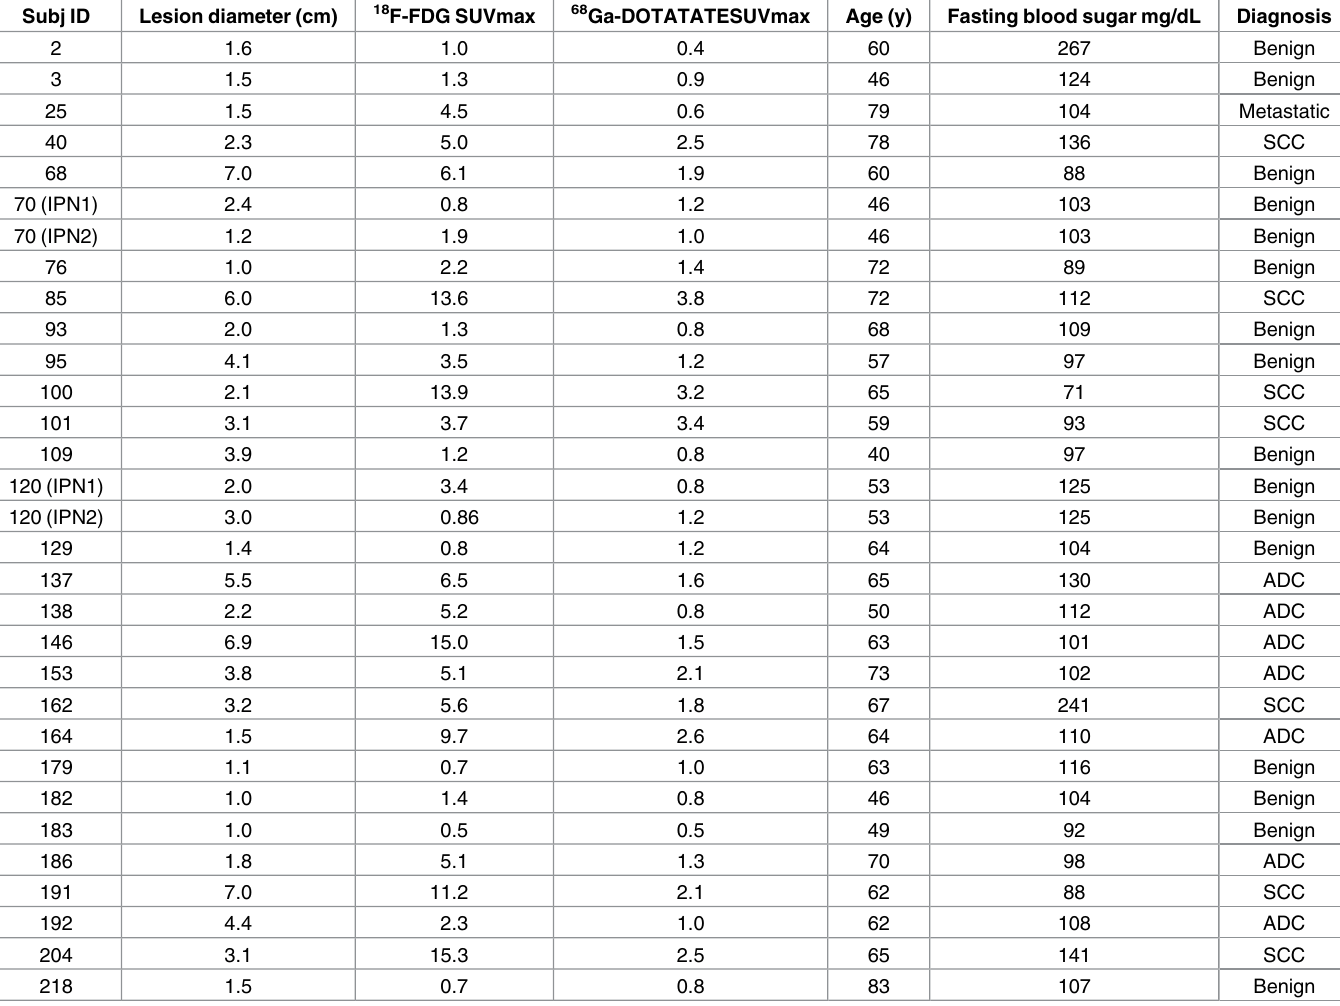
Table 3. Summaryof imaging characteristics (30 patients, 31